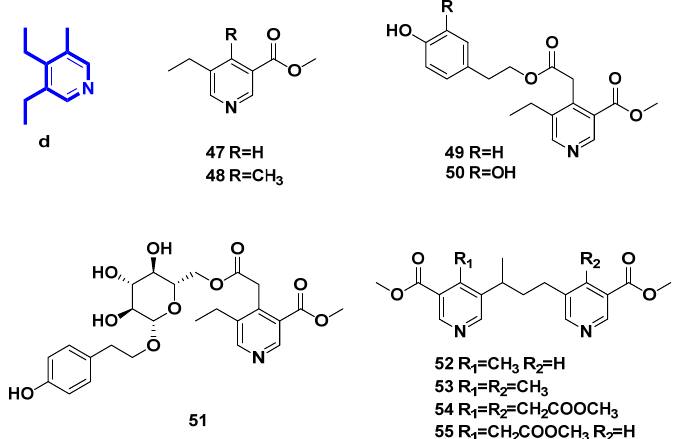
Figure 5. Structures of pyridine alkaloids derived from secoiridoids (Type IV).